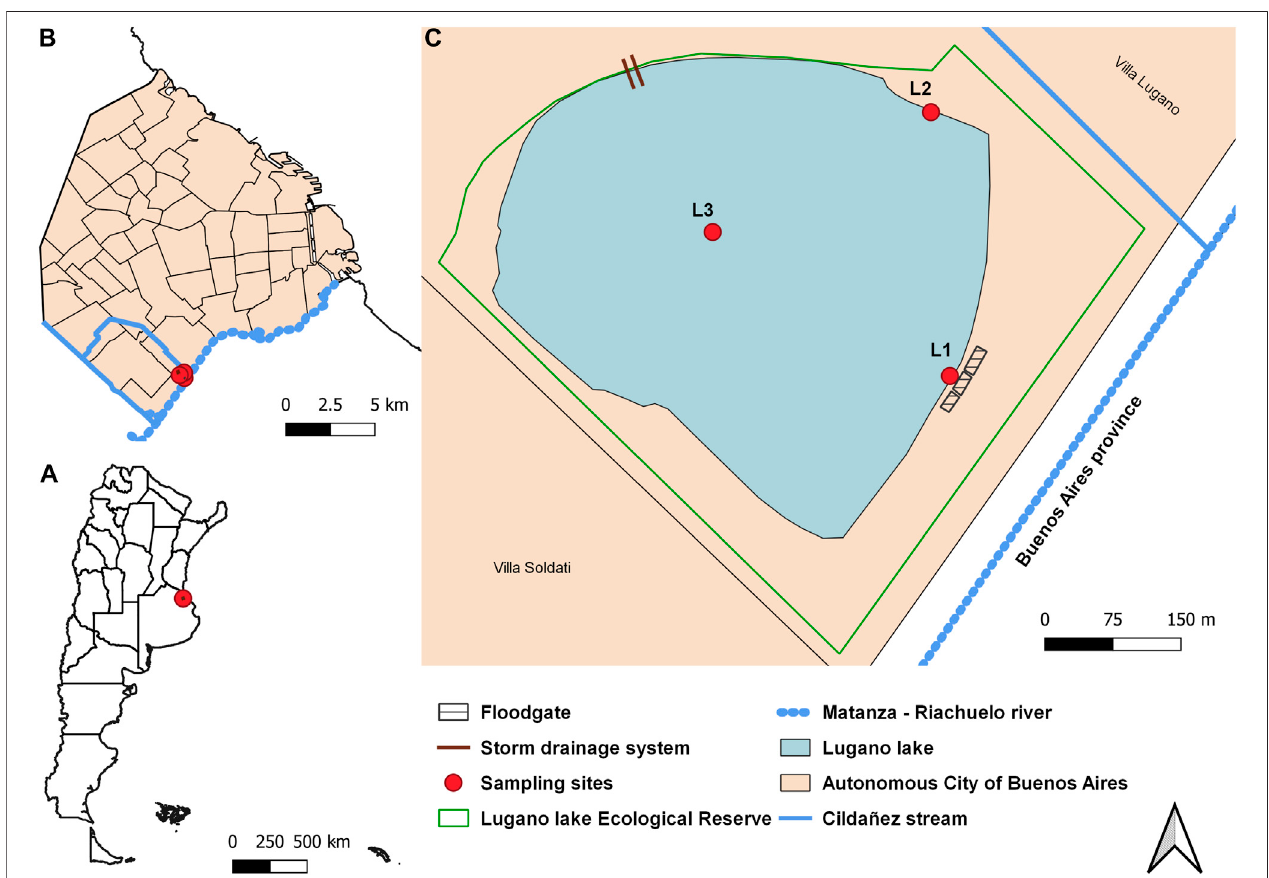
FIGURE 1 | Geographical location. (A) : Argentina, (B) : Buenos Aires City, (C) : Lugano Lake inside of the Ecological Reserve and samples sites (L1, L2, and L3).